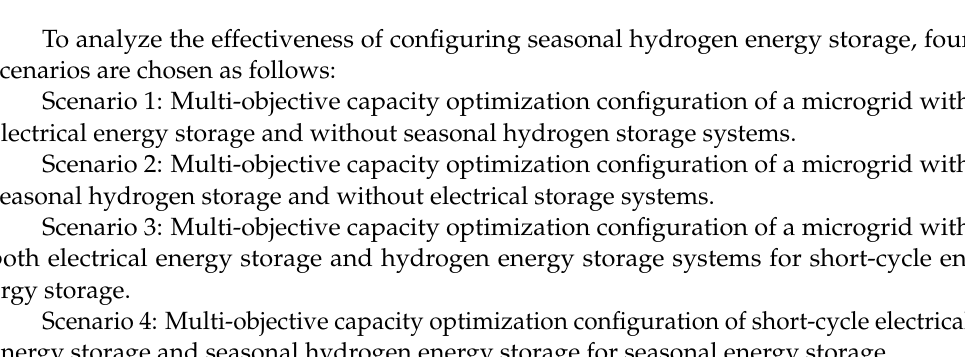
Figure 4. Annual wind power photovoltaic and load power data.